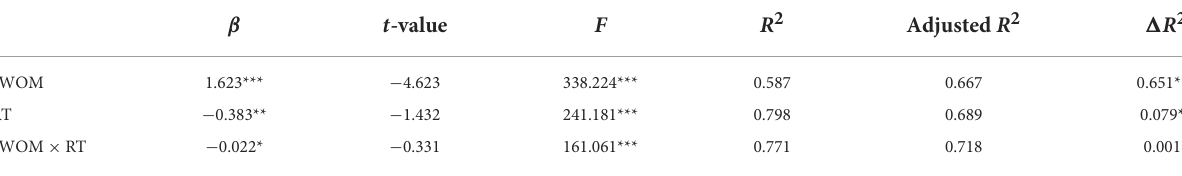
TABLE 7 The moderating effect of risk-taking in